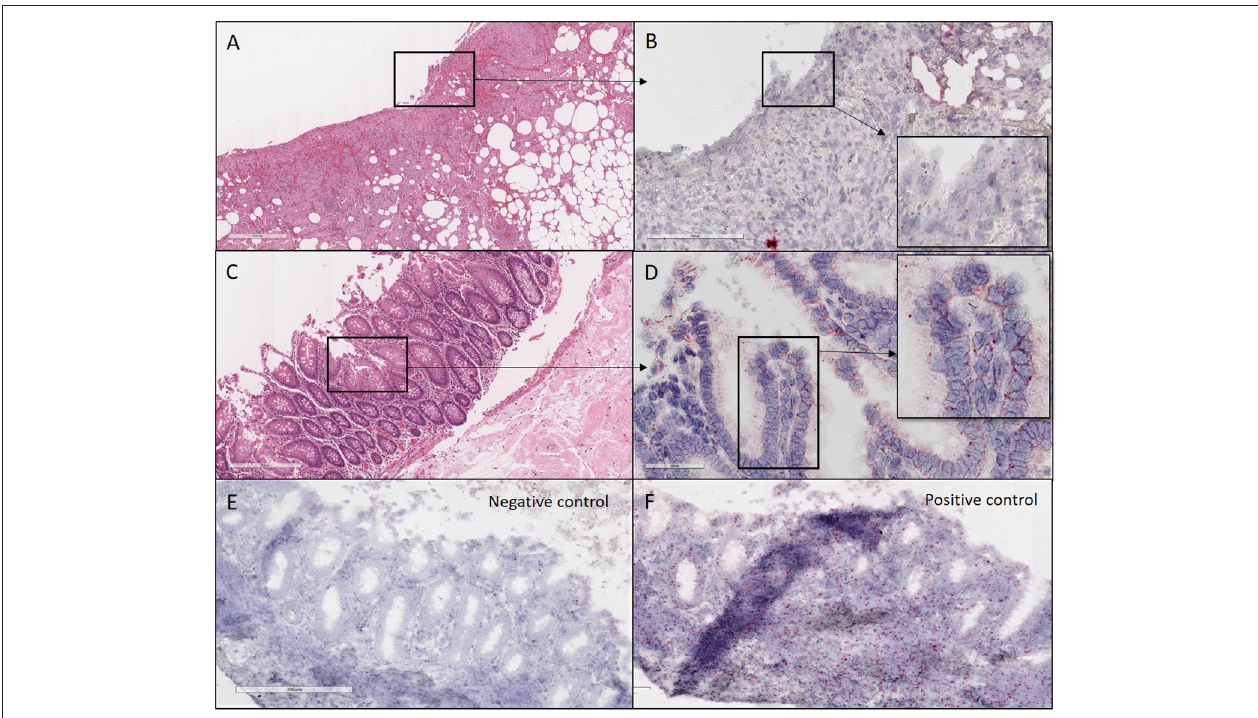
FIGURE 2 | H&E and ISH images of patient #1 in focal mucosal ulcer with granulation tissue formation along with adjacent uninvolved mucosa. (A) H&E images of ulcerated colon tissue at 4X magnification (B) Images at 20X magnification after in situ hybridization using V-nCOV2019—orf1ab–sense probe (cat # 859151-C2), ACD, Bio-techne, detecting replicating SARS-COV-2 RNA (red chromogen) in ulcerated colon tissue sections. (C) H&E images at 10x magnification of adjacent uninvolved mucosa (D) . Higher magnification images at 40X after in situ hybridization using V-nCOV2019—orf1ab-detected as red signal in adjacent uninvolved mucosa. (E) Negative control images at 10X after in situ hybridization using probe (cat # 320751), ACD, Bio-techne, targeting DapB (Bacillus subtilis stain) which did not detect any staining (F) . Positive control images at 10X after in situ hybridization using probe (cat # 321641), ACD, Bio-techne, demonstrated strong positive staining (red chromogen) in sections probed for the housekeeping gene